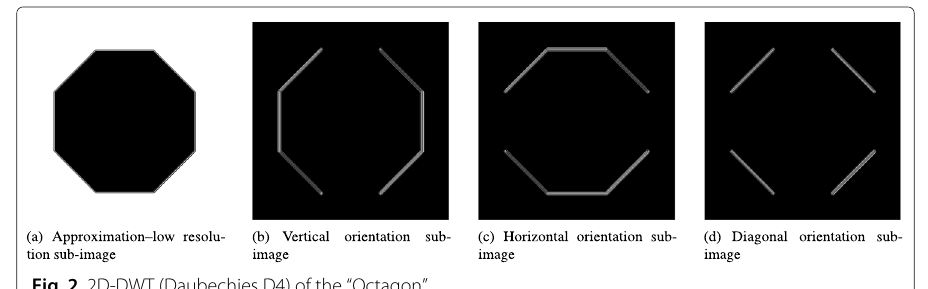
Fig. 2 2D-DWT (Daubechies D4) of the